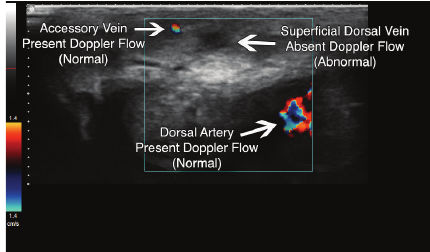
Figure 3: Color Doppler ultrasonography showing absent flow in right superficial vein when compared to accessory vein and dorsal artery, which both demonstrate normal flow (depth set at 2